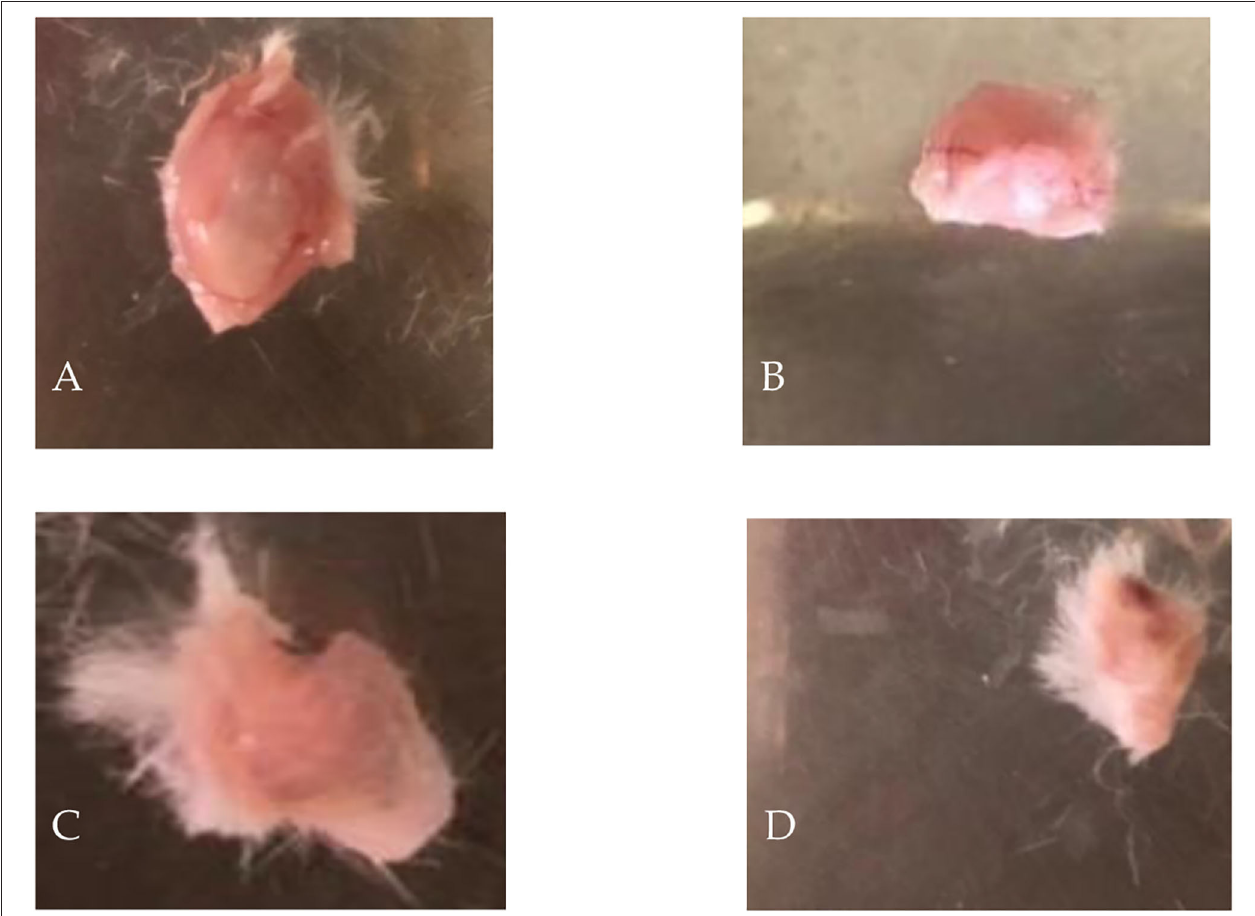
FIGURE 7 | Dissected EMT6/P tumors showing: (A) negative control, (B) given 10% of barley bran, (C) given 20% of barley bran, (D) given 30% of barley